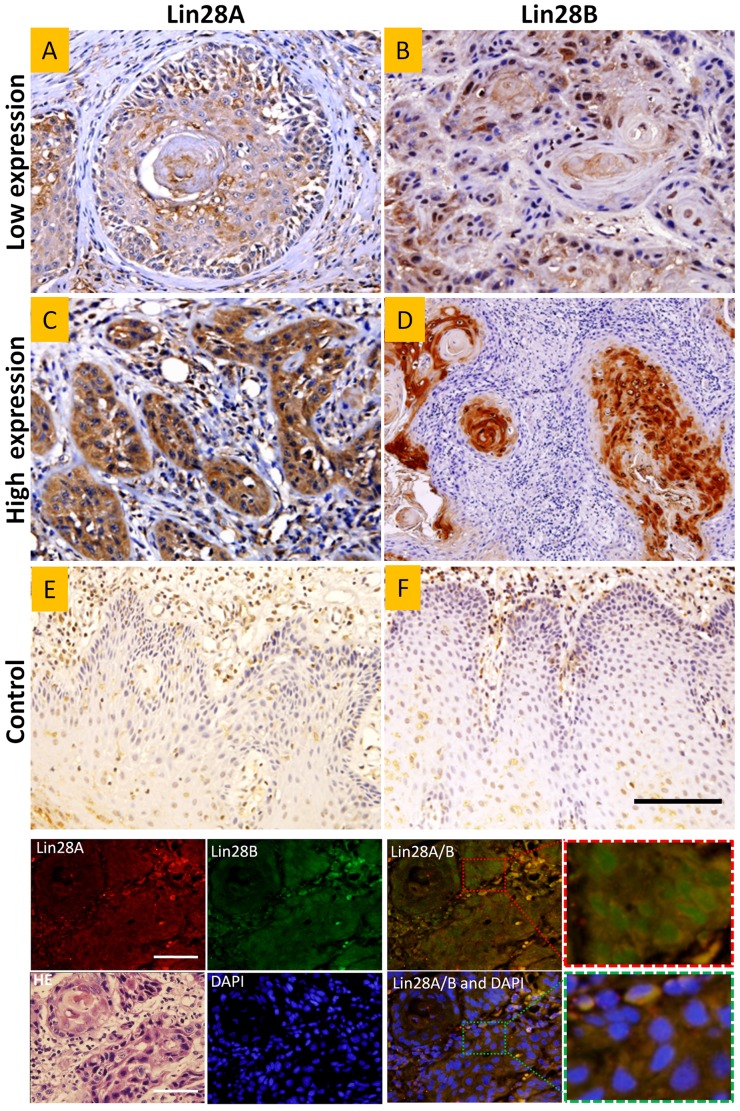
Expressions of Lin28A and Lin28B in OSCC and control tissues. Upper immunohistochemical picture.Representative low (A, B) and high (C, D) Lin28A and Lin28B expression in OSCC specimens and Lin28A and Lin28B expression in control tissues (E, F). Black bar = 50 µm; Lower immunofluorescence picture: Double-label immunofluorescence histochemistry of an OSCC nest showed Lin28A mainly located in the cytoplasm, while Lin28B mainly located in the nucleus. The section was re-stained by hematoxylin and eosin (HE) as shown in the lower left. White bar = 20 µm.